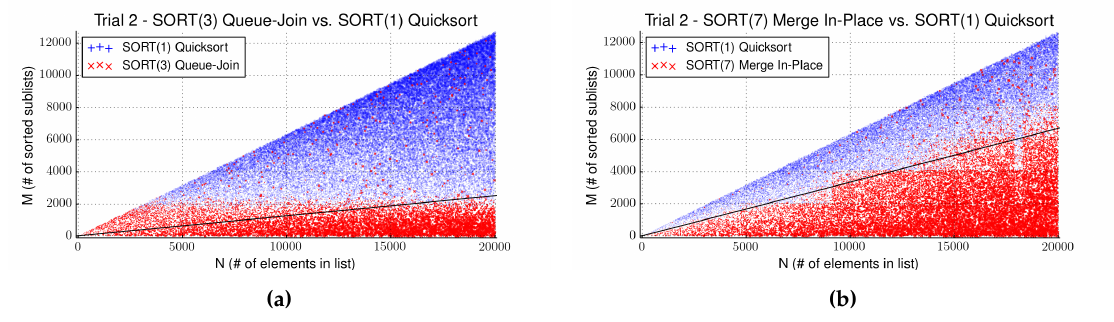
Figure 3. Runtime gain of individual data points of for ( a ) Algorithm 3 and ( b ) Algorithm 7 against Algorithm 1 in Trial 2. Points are plotted when one algorithm performed better than the other with point sizes relative to the gained time. Separators are indicated by a black line. In ( b ), please note that the distribution of red points is less dense above the separator than it is below.